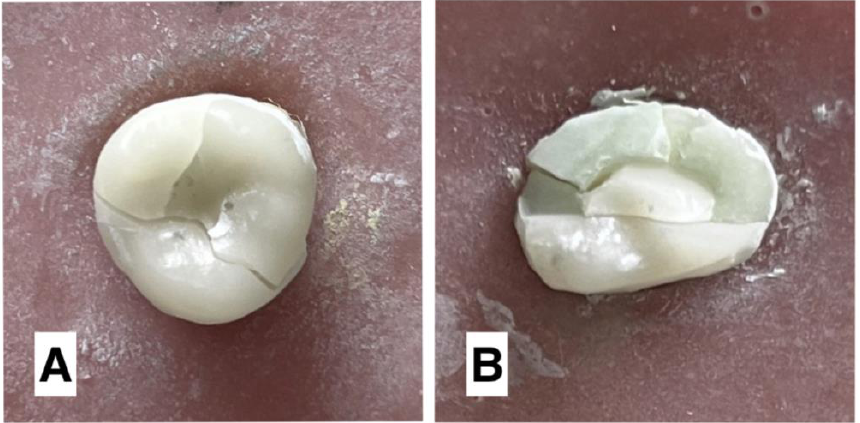
Figure 5. Two specimens with different failure modes of conventional endocrown design ( A ) and endocrown with proximal